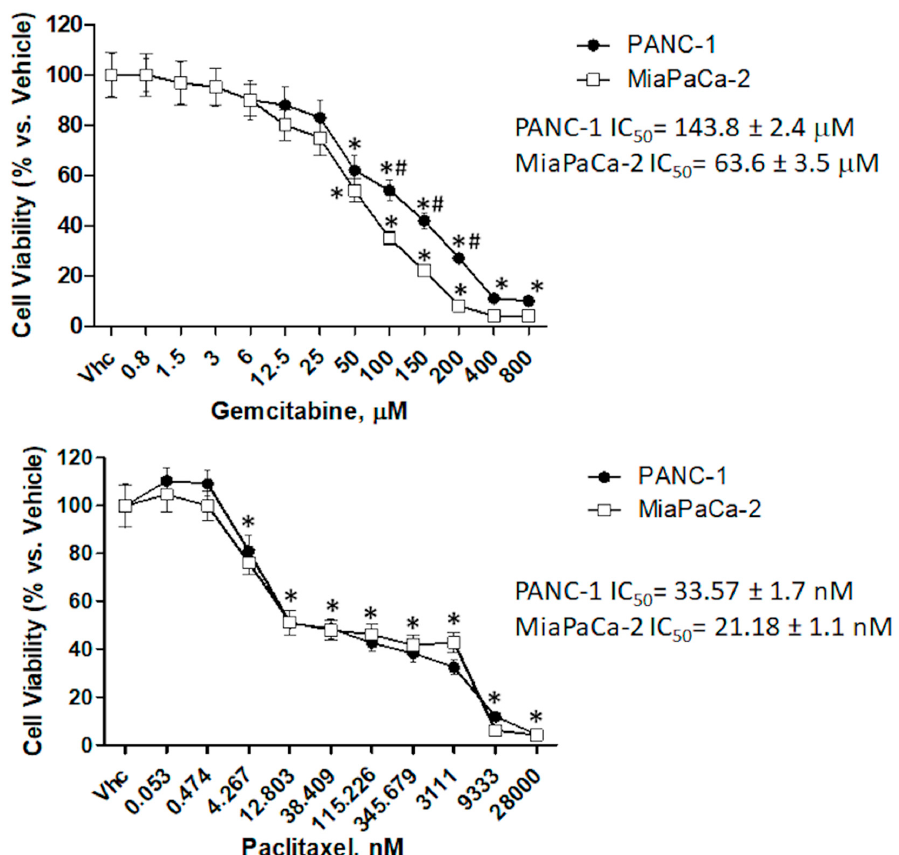
Figure 5. Cytotoxic effect of chemotherapeutic drugs in PDAC cell lines. Cell viability was determined by MTT assay. PANC-1 and MiaPaCa-2 cells were treated for 72 h with different concentrations of gemcitabine (GEM) (up to 800 μ M) or paclitaxel (PTX) (up to 28 μ M), in single administration. Data shown are expressed as mean ± SE of three separate experiments. * p < 0.05 treated vs vehicle, # p < 0.05 PANC-1 vs. MiaPaCa-2.